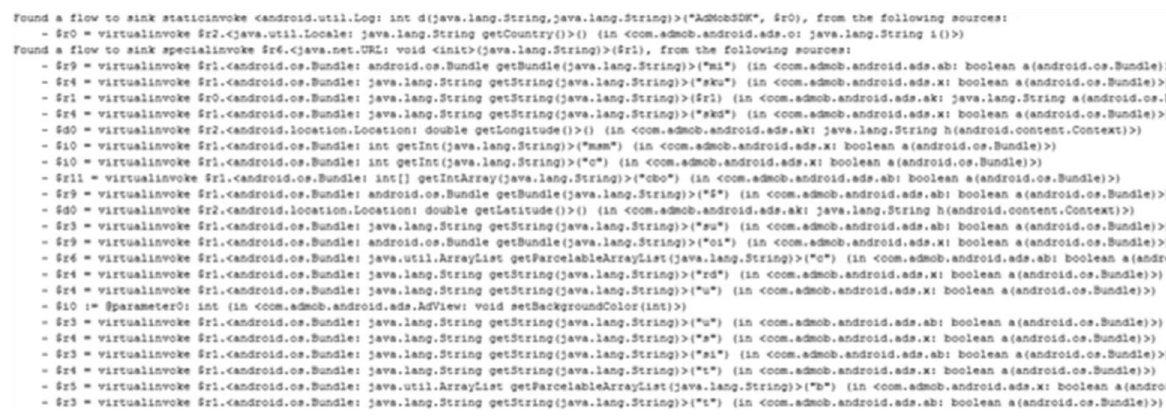
Fig. 4 Sample FlowDroid results for Adobe Reader App. Sinks are shown on lines beginning with “ Found a flow …” and sources that flow to the sink are on the dashed lines